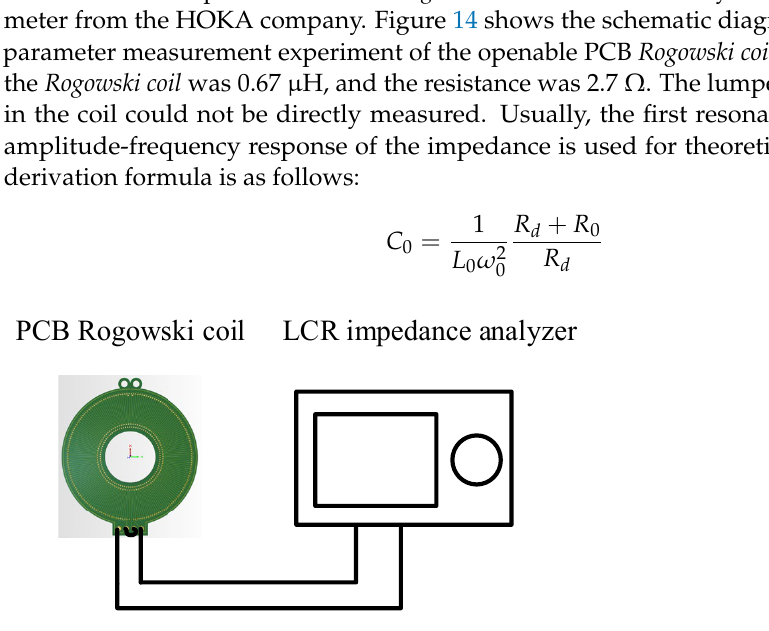
Figure 14. Experimental diagram of the coil electrical parameter measurement.